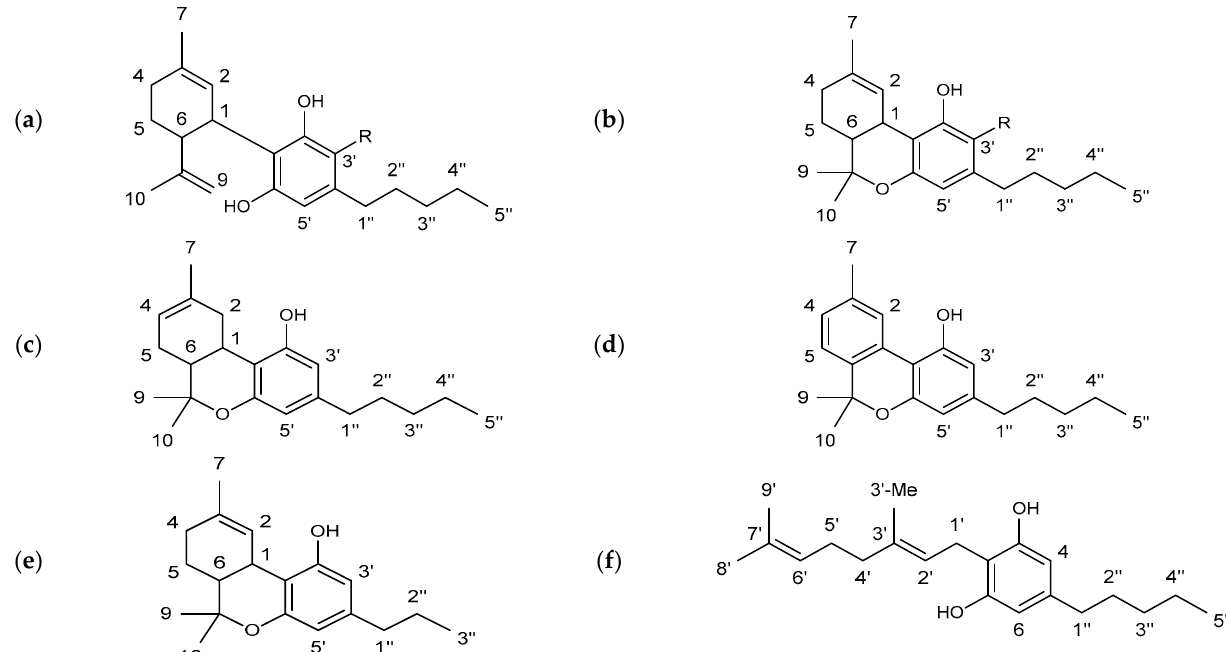
Figure 1. Chemical structures of the main cannabinoids studied in this work including the applied numbering system. ( a ) R = H: cannabidiol (CBD), R = COOH: cannabidiolic acid (CBDA); ( b ) R = H: ∆ 9 -tetrahydrocannabinol ( ∆ 9 -THC), R = COOH: ∆ 9 -tetrahydrocannabinolic acid A (THCA); ( c ) ∆ 8 -tetrahydrocannabinol ( ∆ 8 -THC); ( d ) cannabinol (CBN); ( e ) ∆ 9 -tetrahydrocannabivarin (THCV); ( f ) cannabigerol (CBG).